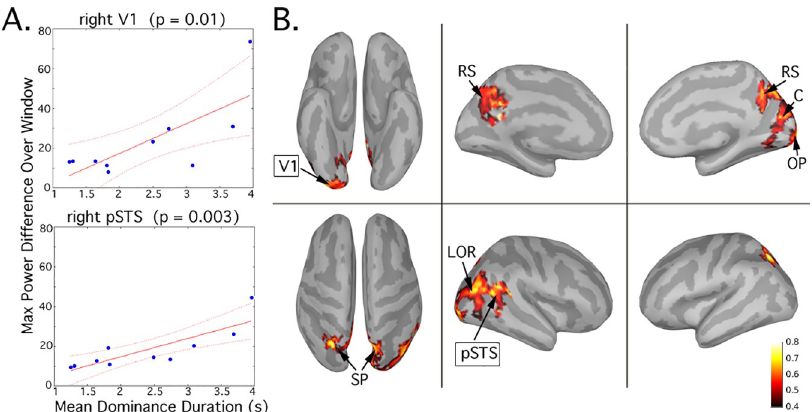
Fig 5. BR mean dominance durations vs. maximum change in 2.5Hz power over the window of interest. A. (top) For right V1, the power envelope at 2.5Hz is extracted from trials classified as pure to mixed, then averaged. The maximum change in power (maximum minus minimum) over the window (-300,1000) milliseconds is computed and correlated with the BR mean dominance durations for the subjects. A. (bottom) The same correlation is shown for right pSTS (posterior superior temporal sulcus) B. Correlations over the entire cortical surface (15,000 sources) with p < 0.05 in clusters > 200 vertices are shown in heat map on the cortical surface.